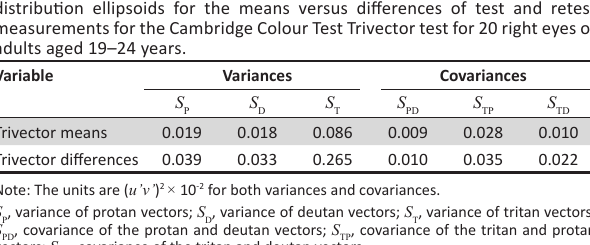
FIGURE 6: A stereo-pair scatter plot of means versus differences of test and retest measurements with 95 % distribution ellipsoids for 20 adults aged 19–24 years. The cyan points (and ellipsoid) represent means of test and retest measurements, and the magenta points (and ellipsoid) represent the differences of test and retest measurements. The black comets link participant test and retest means to their corresponding test and retest differences. The origin is at 0 u ’ v ’ units and the axis lengths are 0.01 u ’ v ’ units. TABLE 4: Variances (first three columns) and covariances of the 95 % distribution ellipsoids for the means versus differences of test and